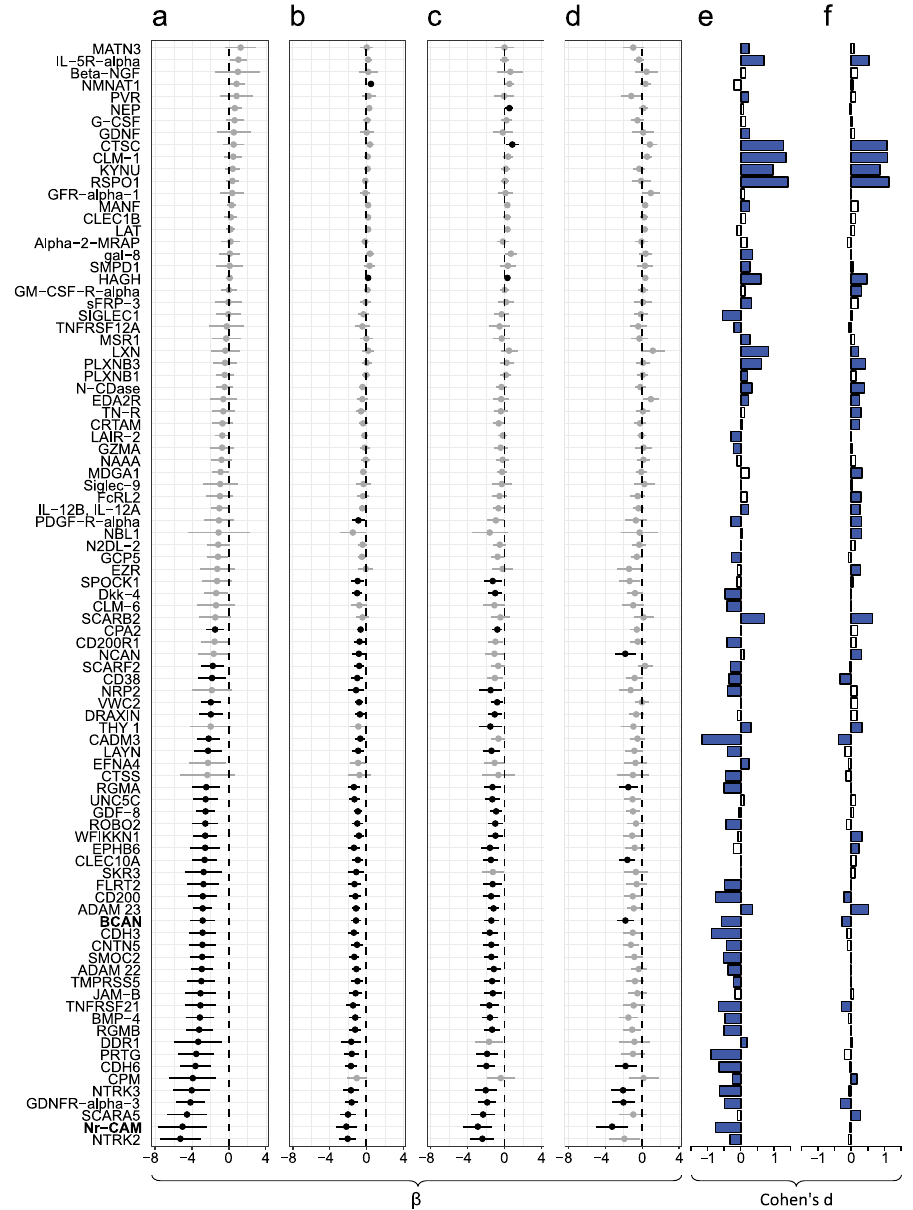
Figure 1. Associations between plasma protein levels, acute stroke severity and short- and long-term neurological outcome in 209 ischemic stroke cases, and comparisons of plasma protein levels between these cases and controls at the different time-points. Panels ( a – d ): Associations between plasma protein levels (Normalized Protein eXpression [NPX] levels) and degree of neurological impairments according to the NIH stroke scale (NIHSS), visualized with forest plots with β values and 95% confidence intervals derived from multivariable linear regression models adjusted for age, sex, and time until the blood draw (model 1). Associations with false discovery rate (FDR) < 0.05 are marked in black. As the NPX value is given on a log2 scale, the yielded β-value corresponds to the predicted change in NIHSS score per each doubling of protein levels . Associations between: ( a ) plasma protein levels and NIHSS score in the acute stroke phase, ( b ) plasma protein levels in the acute phase and NIHSS score at 3 months post-stroke, ( c ) plasma protein levels in the acute phase and NIHSS score at 7 years post-stroke, ( d ) plasma protein levels at 3 months and NIHSS score at 7 years post-stroke. For BCAN and Nr-CAM (marked in bold), the association between 3-month levels and 7-year outcome withstood additional adjustment for stroke severity. Panels ( e–f ): Differences in plasma protein levels between cases and controls. The bars correspond to Cohen’s d, i.e. the mean difference in case and control levels divided by the standard deviation for the controls, where a positive value indicates higher levels in cases than controls. Blue bars correspond to comparisons with a statistically significant difference (FDR < 0.05). ( e ) Comparison between acute phase samples (cases) and controls. ( f ) Comparison between 3-month samples (cases) and